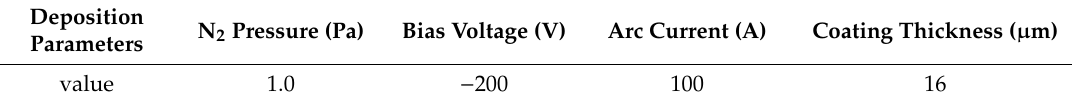
Table 2. Deposition parameters of TiN layer.